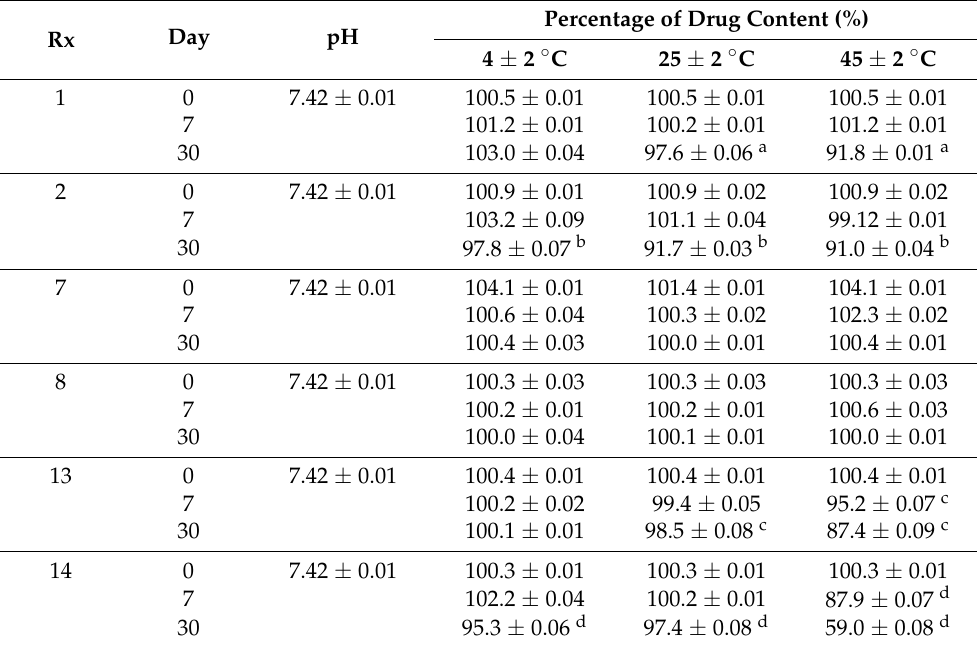
Table 5. The pH of and percentage remaining of fluocinolone acetonide (FA) following storage at 4 ◦ C, 25 ◦ C, or 45 ◦ C (expressed as mean ± standard deviation, n =